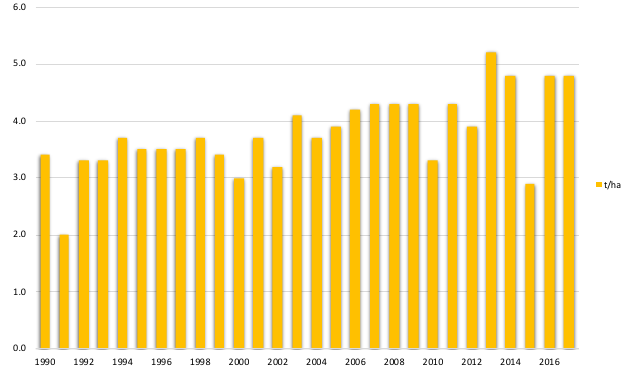
Figure 2. Maize Yield for the Azuero region (1990–2017). Source: MIDA